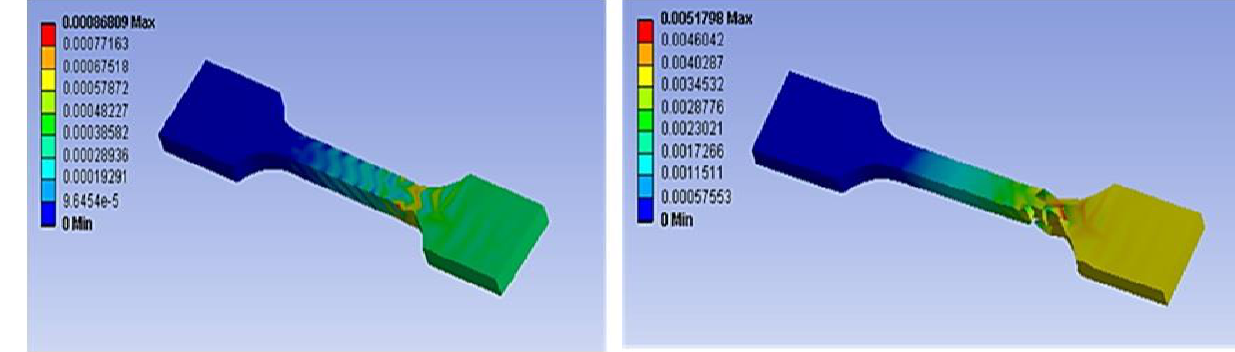
Figure 6. Finite element results.